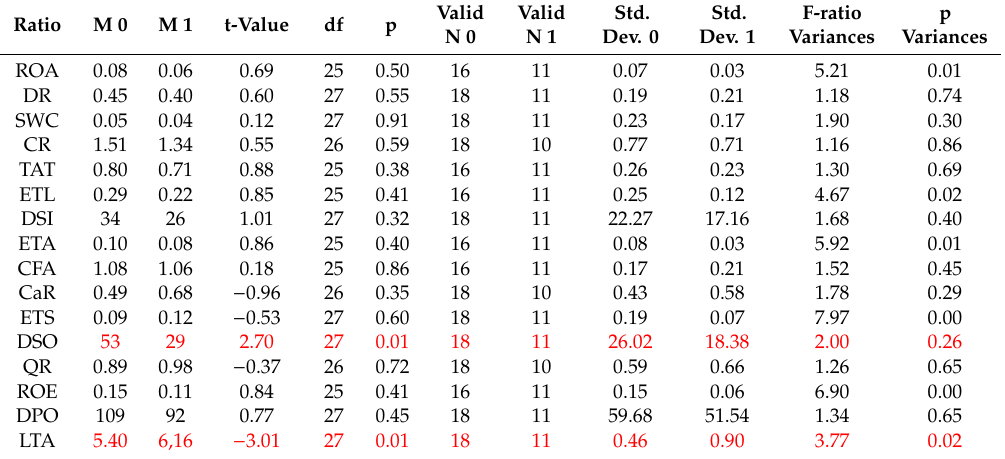
The red color means that di ff erences in the values of individual indicators are statistically significant. Table A7. The student’s t-test results for the chosen ratios for green (1) and red (0) companies for 2011.